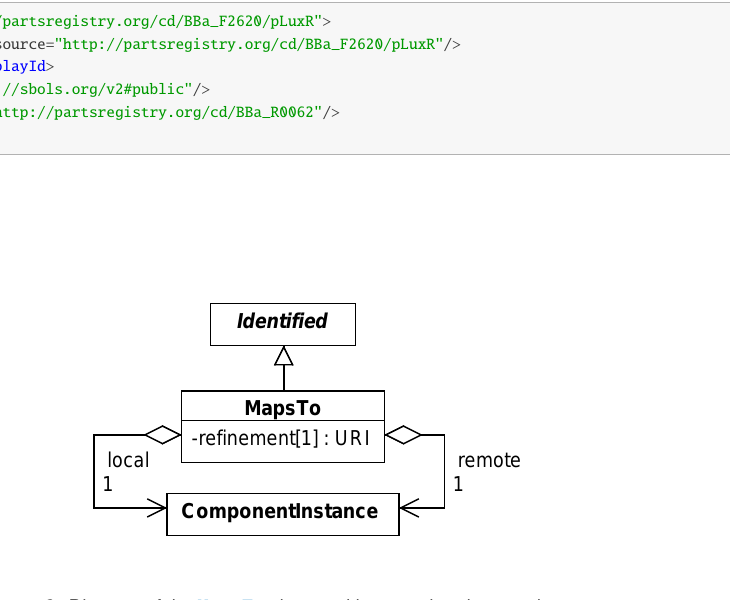
Figure 9: Diagram of the MapsTo class and its associated